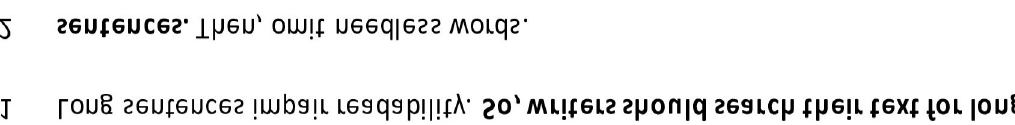
Fig 3. Conceptual visualization of upside-down text. Participants judged whether the target sentence (bolded) on each trial contained more or fewer than 17 words.